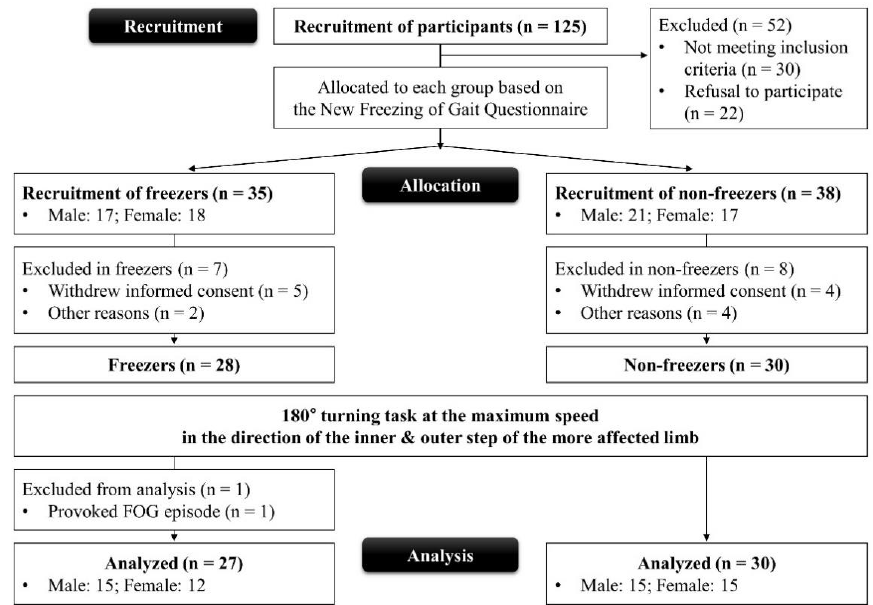
Figure 1. Study flow chart. FOG, freezing of gait. Table 1. Physical and clinical characteristics of all participants.